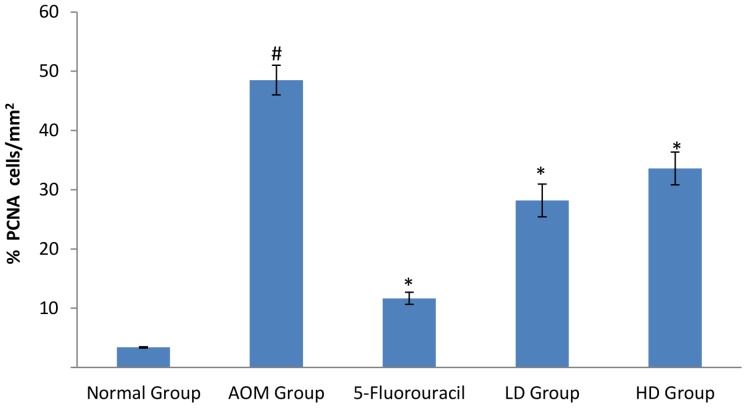
Effects of A. ilicifolius on PCNA counting.All values are expressed as the mean ± SEM. *  =  significantly different means compared to the AOM group, mean with #  =  significantly different means compared to the normal group, p<0.01.